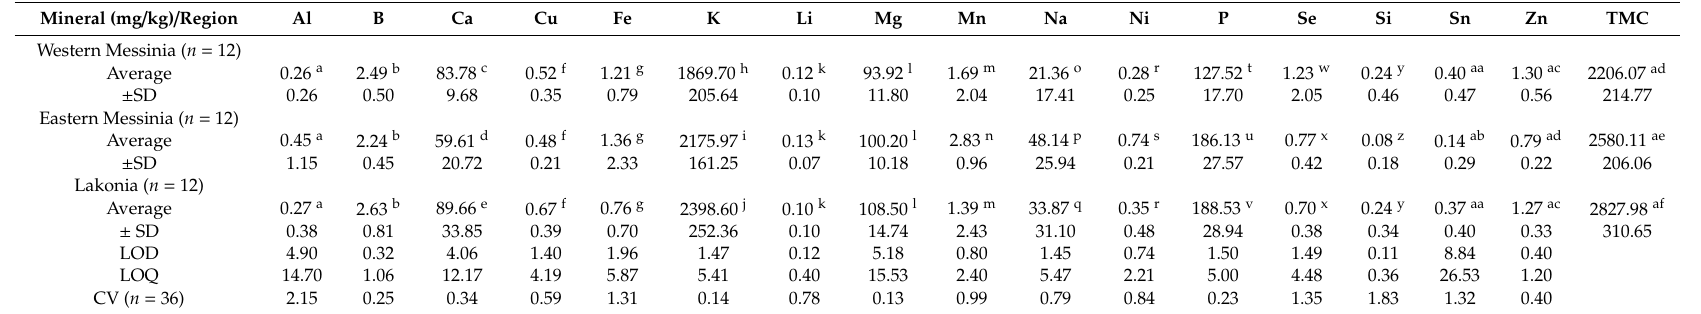
Table 1. Mineral content of prickly pear juice of di ff erent geographical